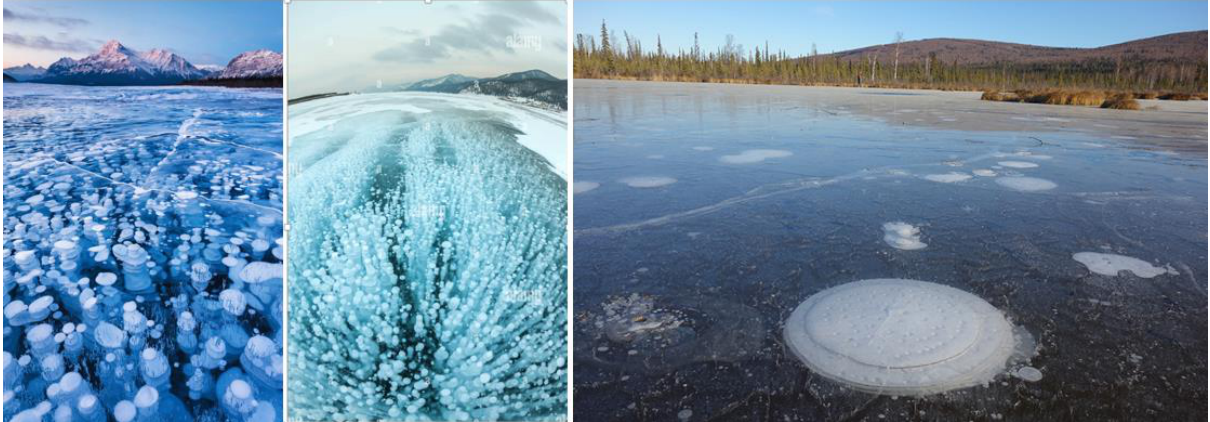
Figure 9. Methane bubbles under Lake Abraham (1st photo) and in the frozen waters of the Tundra (sources, [104 – 106]).